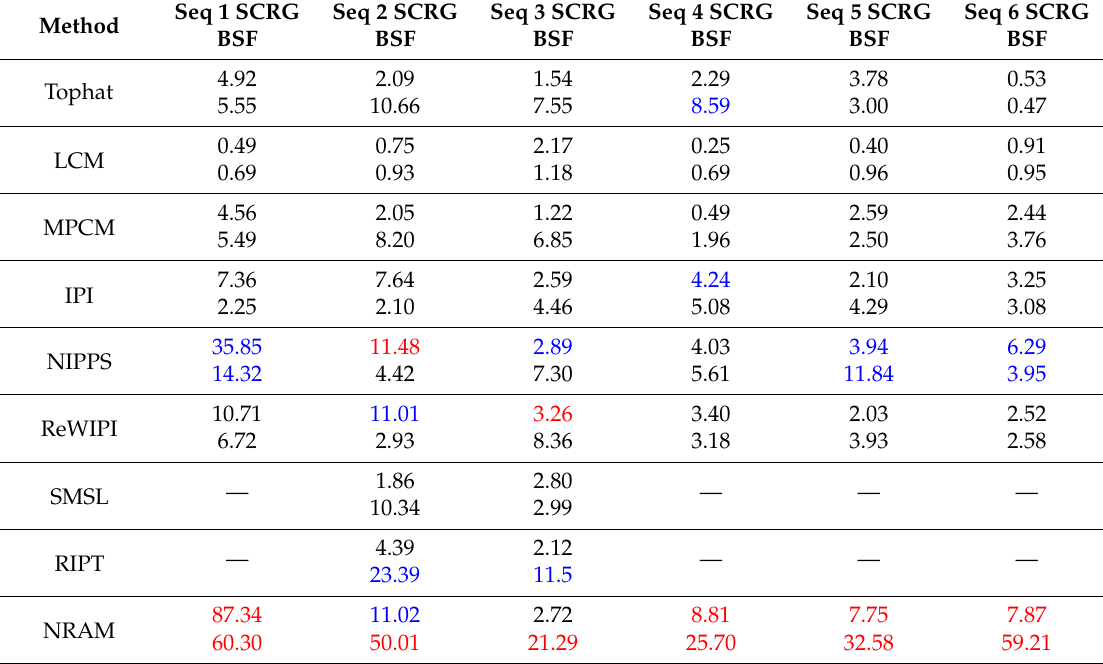
Table 4. SCRG and BSF values of the nine methods.